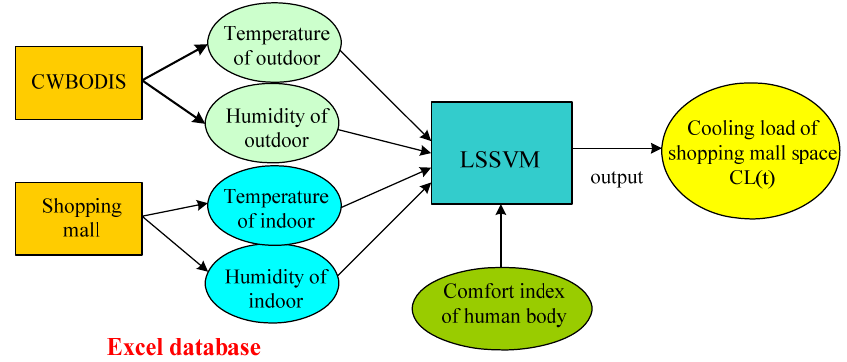
Figure 2. The cooling load forecasting of shopping mall by using the LSSVM.